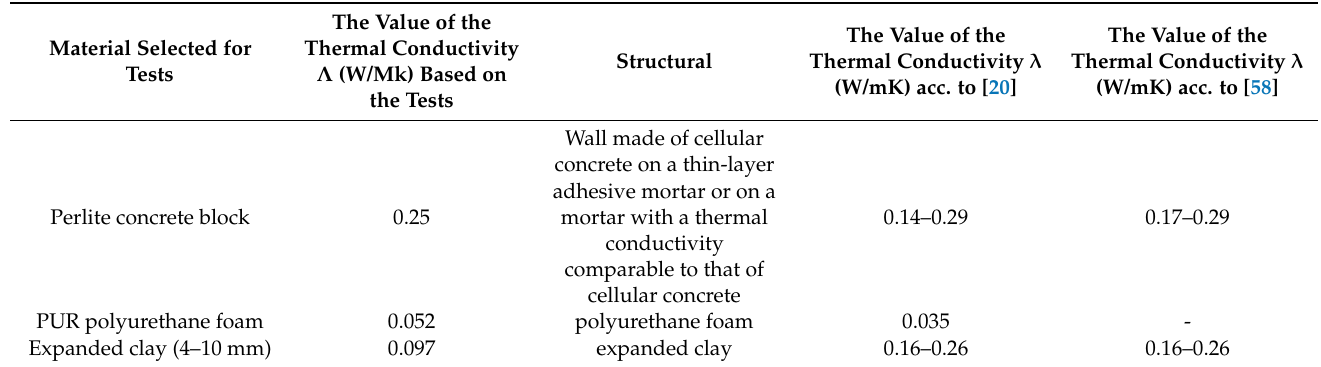
Table 5. Summary of the values of the thermal conductivity of the tested samples and corresponding materials according to [20,58] at the temperature of 20 ◦ C and humidity